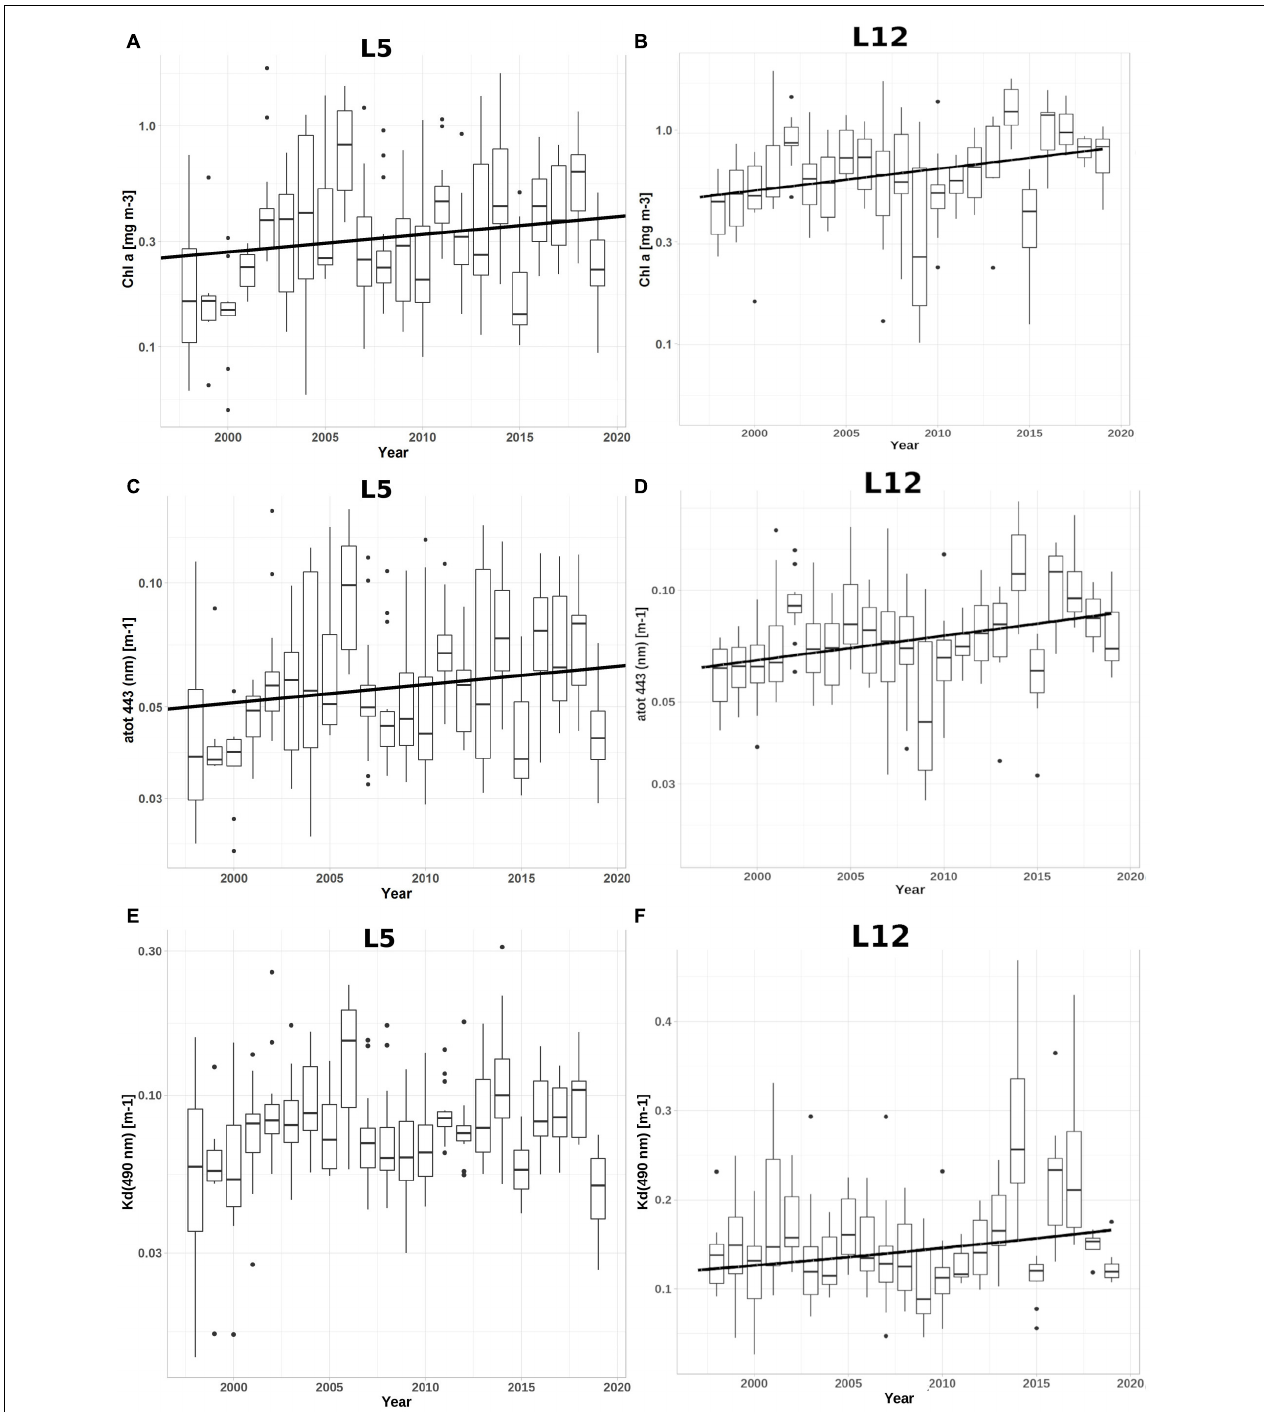
FIGURE 5 | Boxplots of Chla (A,B) – 1st row, a tot (443) (C,D) – 2nd row, and K d (490) (E,F) – 3rd row values during summer season in years 1997 – 2019 with increasing trends ( p -value < 0.01) marked with black lines at locations L5 (A,C,E) and L12 (B,D,F) ( Figure 1 ).